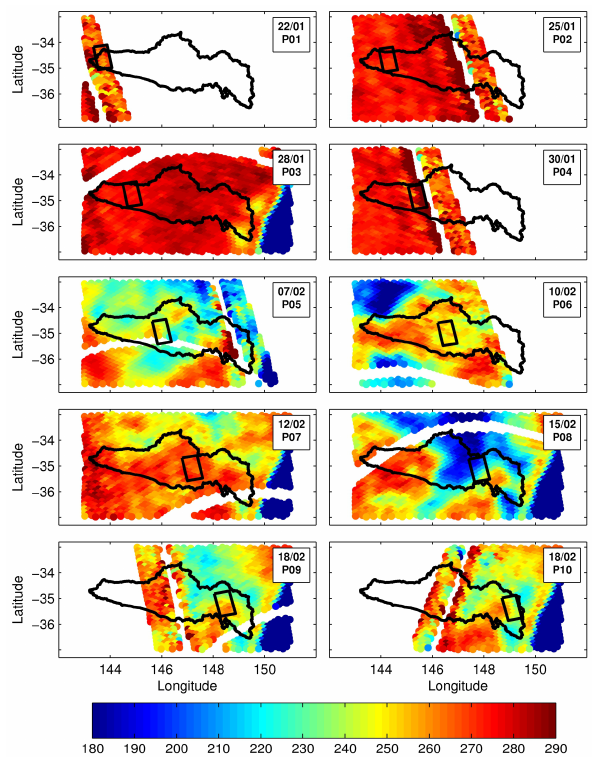
Fig. 7. Temporal and spatial patterns of H-polarized SMOS L1C brightness temperature data [K] collected during the summer field campaign (AACES-1). Overlain are the Murrumbidgee catchment boundary and the individual flight patch of that particular day, where airborne L-band data is available.